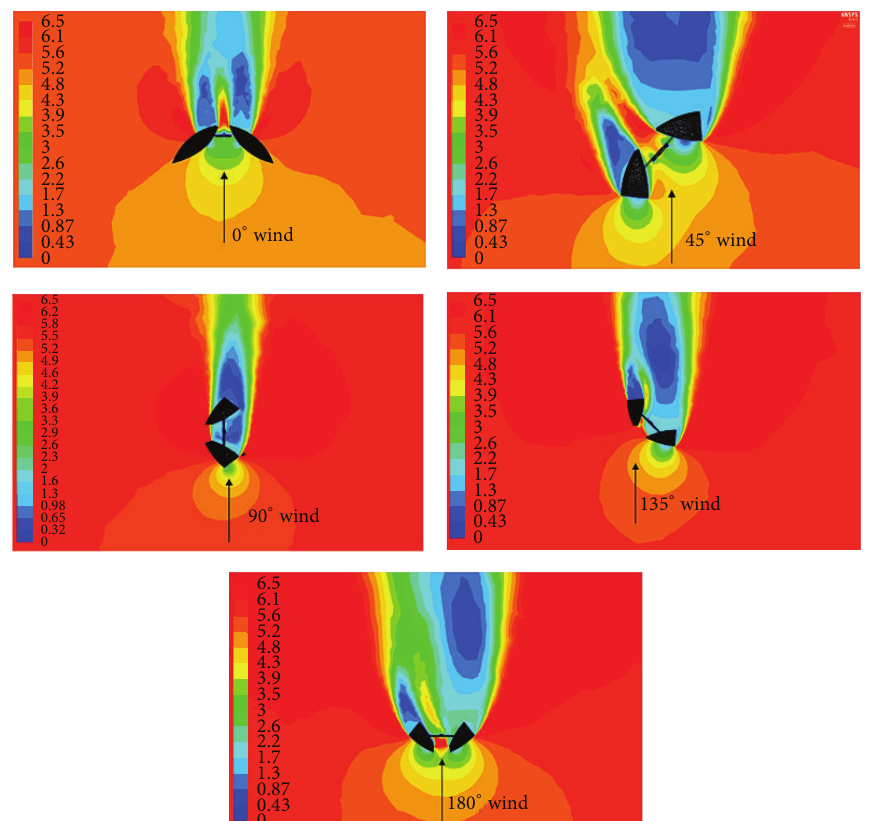
Figure 12: Contour levels showing the wind velocity at high altitude (Wind Turbine 3) at different wind angles.